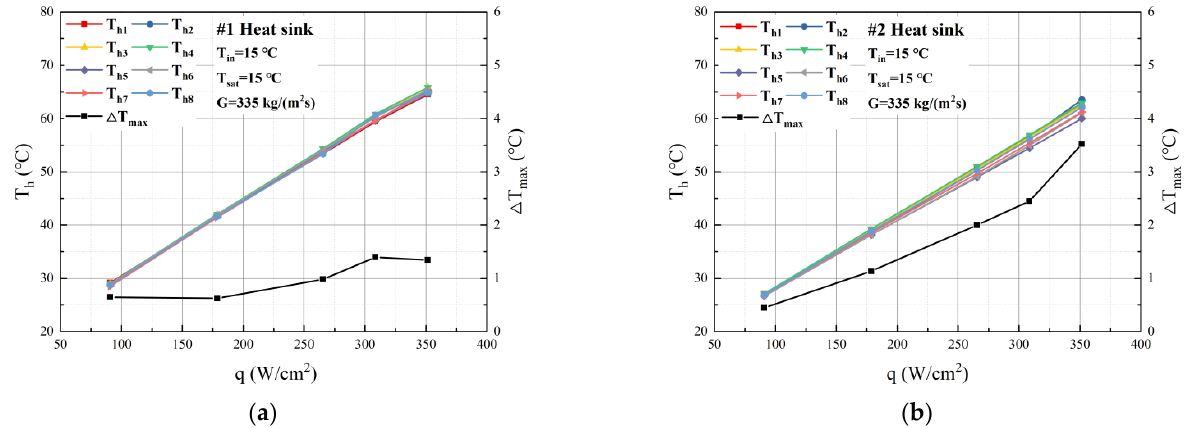
Figure 5. Heat dissipation performance of heat sink at different heat fluxes. ( a ) #1 heat sink ( b ) #2 heat sink.